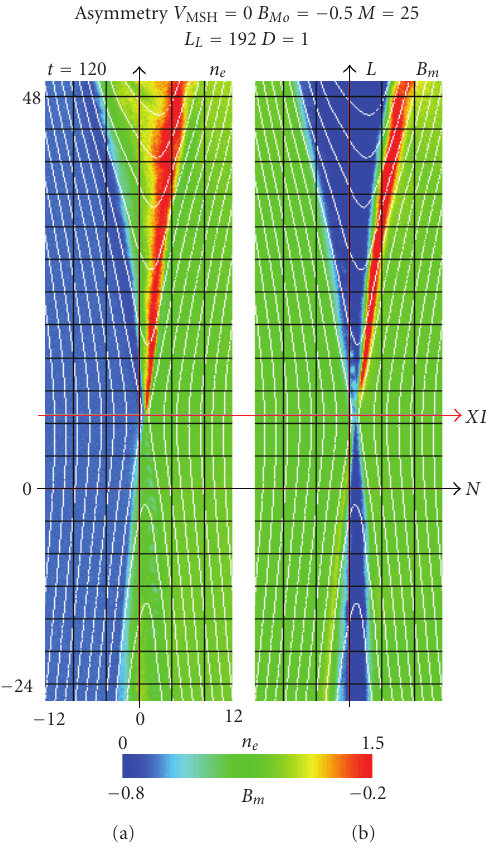
Figure 14: Two-dimensional contours of (a) density and (b) out- of-plane magnetic field for the low mass ratio/larger simulation box case. The peculiar features in density and in B M seen in the upward- directed jet are not local to the X-line but are extended away from